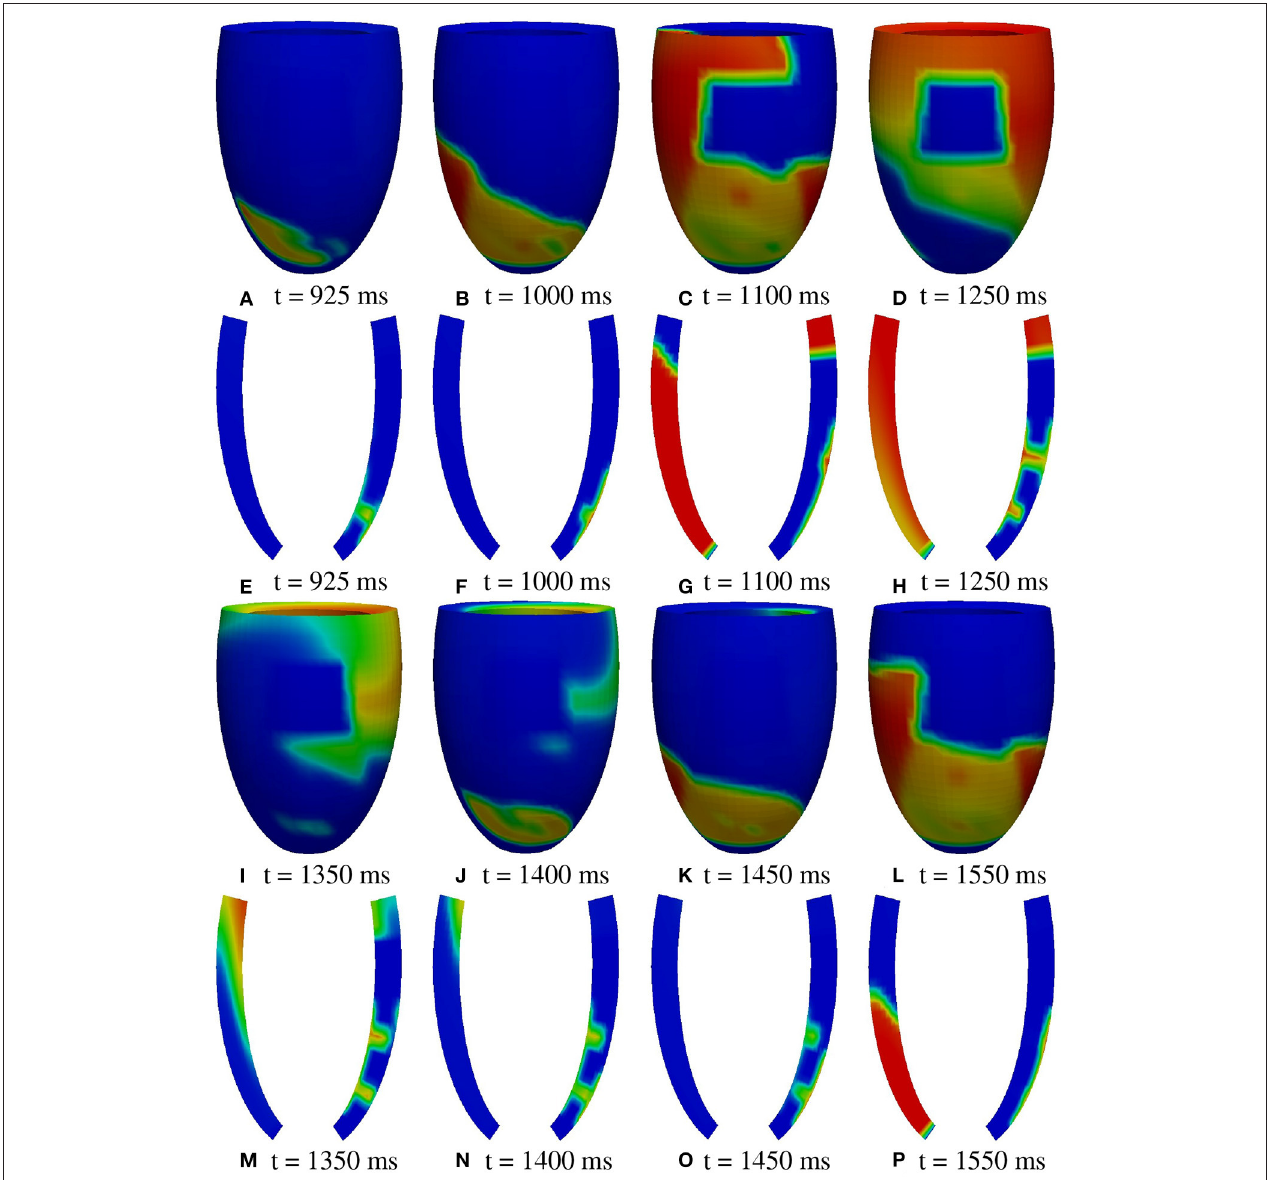
FIGURE 8 | Patient #1. A2 stimulation. (A–P) Transmembrane potential snapshots (t = 925–1550 ms) on the epicardial surface and on a transmural section. t = 0 corresponds to the S1 stimulus. The S2 stimulus is applied at t = 350 ms. The colorbar is the same as in Figure 5 .